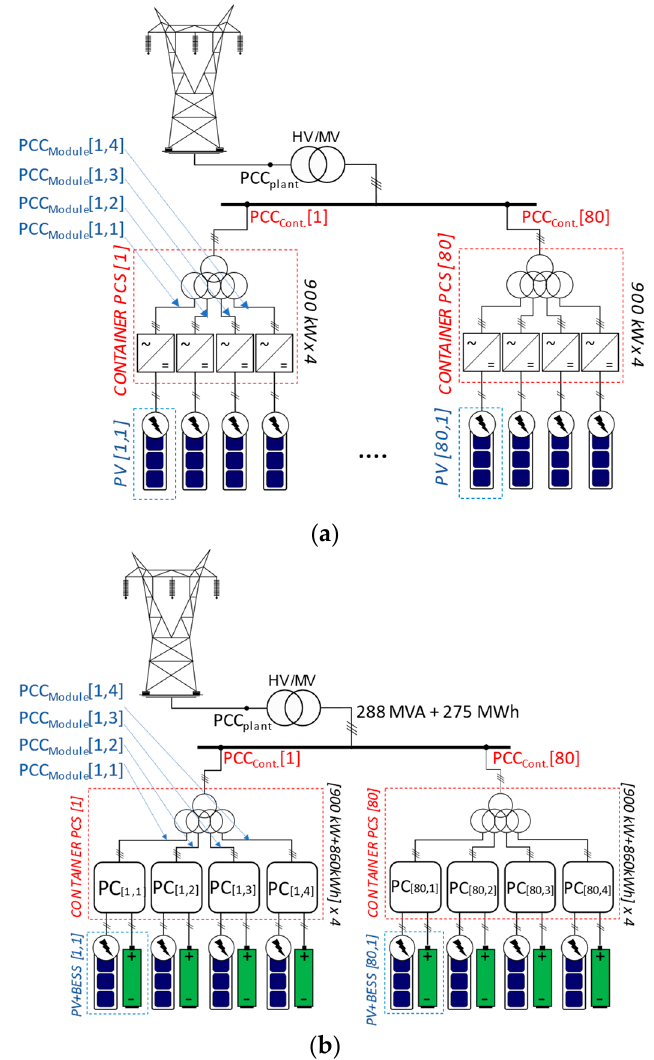
Figure 1. ( a ) A modular 288 MWp PV power plant made of 80 separate PCS, each including 4 PV inverter modules with a 900 kVA rating. ( b ) Modular integration of the 92.2 MW/275.2 MWh BESS into the 288 MW PV plant.